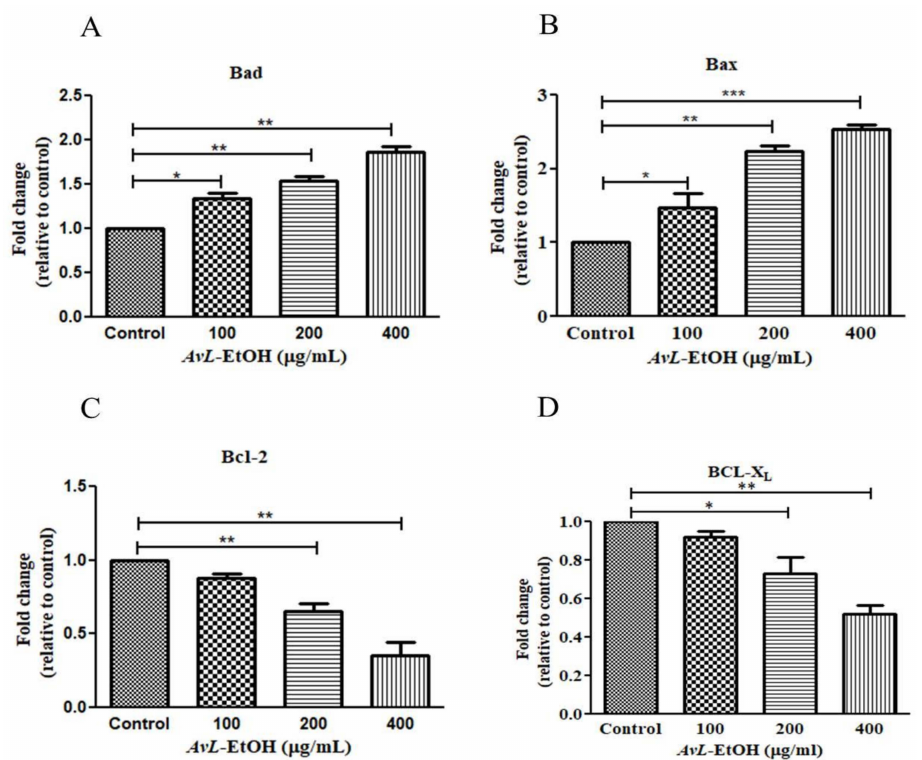
Figure 7. AvL -EtOH instigated changes in the gene expression of ( A , B ) pro-apoptotic (Bad and Bax), ( C , D ) anti-apoptotic (Bcl and Bcl-XL) proteins. * p < 0.05, ** p < 0.01and *** p < 0.001. The loss of ∆Ψ m triggers cytochrome-c release from the mitochondria to the cytoplasm. Cyt c is regarded as the potent activator of the apoptotic caspase cascade. Thus, we determined the effects of AvL -EtOH on ∆Ψ m. Our data suggested that AvL -EtOH treatment decreased ∆Ψ m within the A549 cells (Figures 8 and 9), verifying the involvement of mitochondria in AvL -EtOH-induced apoptosis.